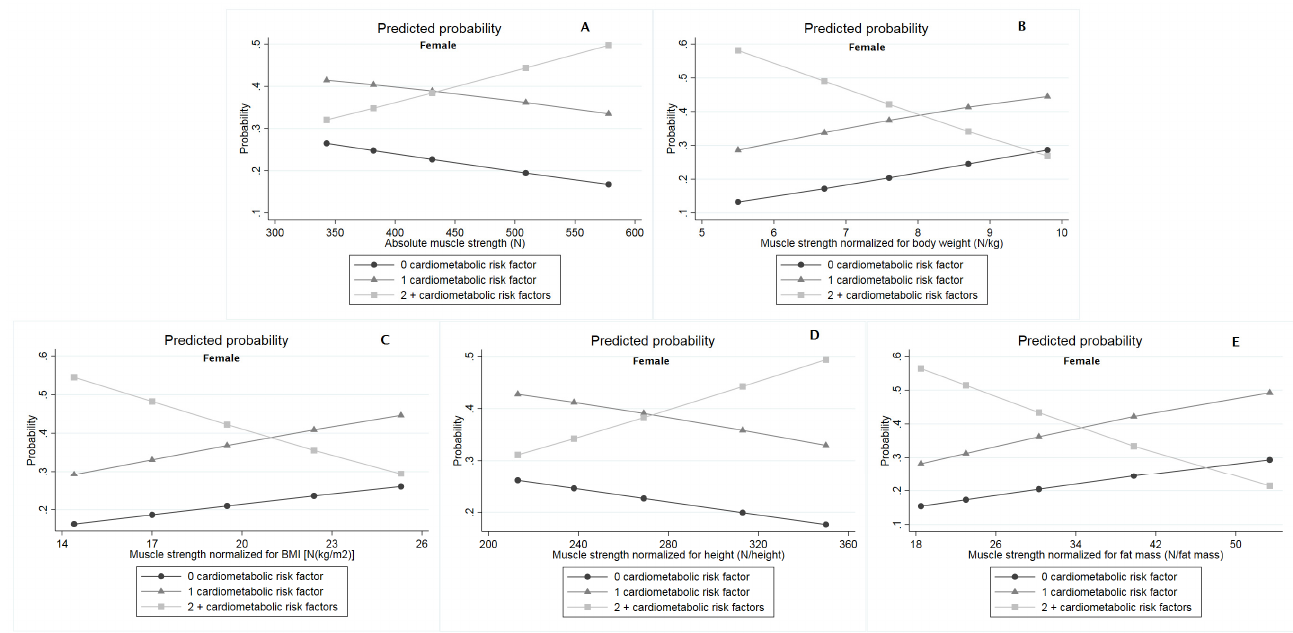
Figure 3. Predicted probability from multinomial logistic model for the adjusted relationship between muscle strength indices with cardiometabolic risk factors among females. ( A ) Absolute muscle strength (N); ( B ) Muscle strength normalized for body weight (N/kg); ( C ) Muscle strength normalized for BMI [N/(kg/m 2 )]; ( D ) Muscle strength normalized for height (N/height); ( E ) Muscle strength normalized for fat mass (N/fat